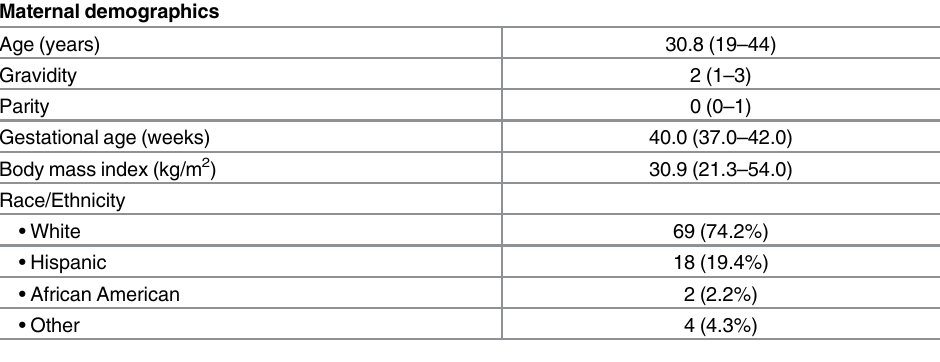
Table 1. Demographic characteristics and clinical information for the study population (n =